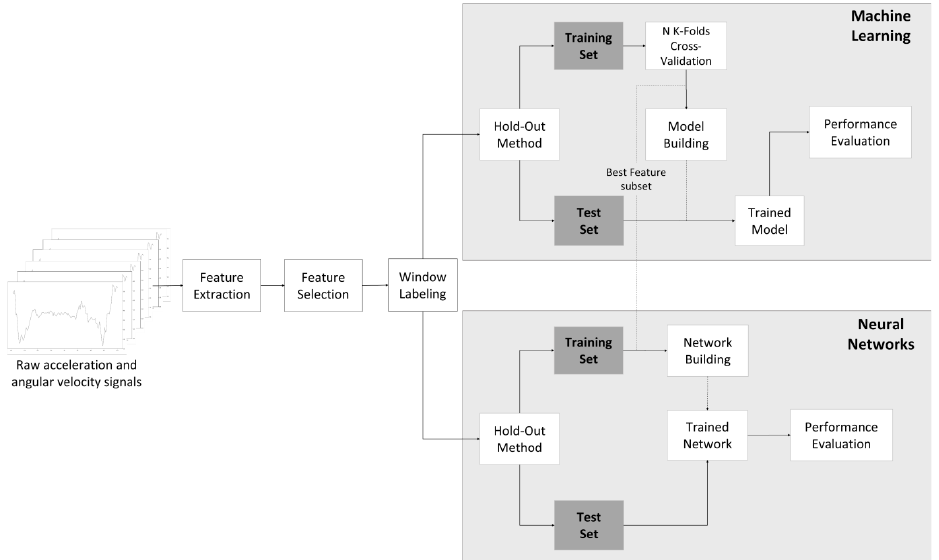
Figure 3. Complete process for all the validation, training and evaluation of different Machine Learning and Deep Learning models alongside the best feature set selected by diverse feature selection